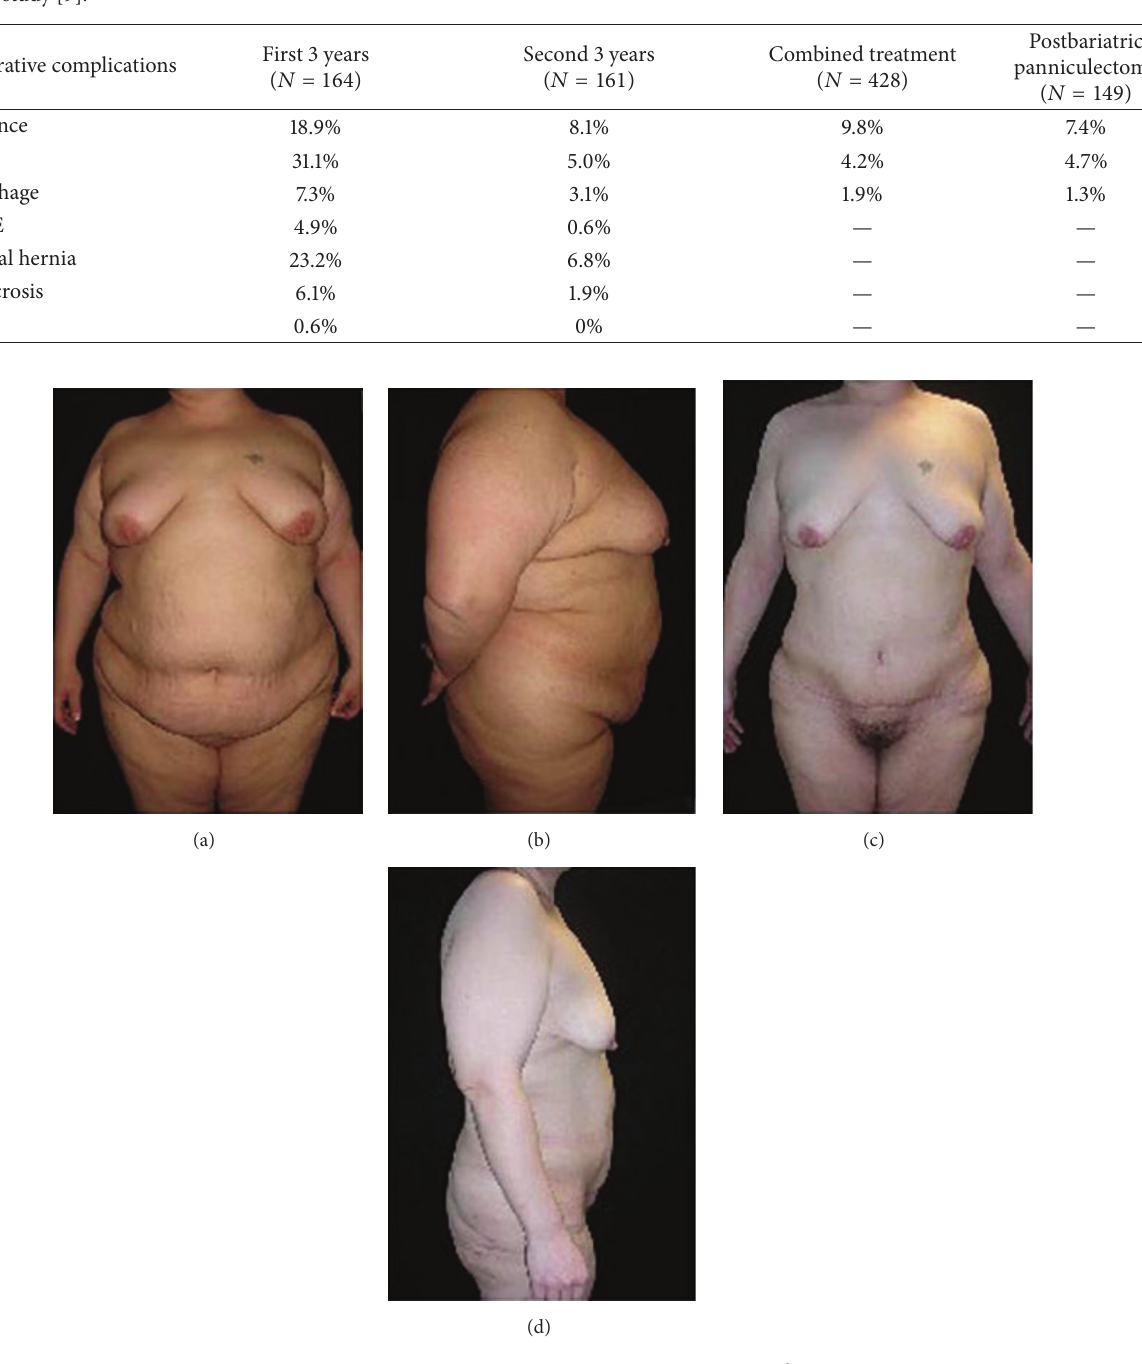
Figure 8: (a) Preoperative frontal view and (b) lateral view of a female patient (BMI = 45 kg/m 2 ; body weight = 133kg). (c) Postoperative frontal view and (d) lateral view 18 months after surgery (body weight = 72